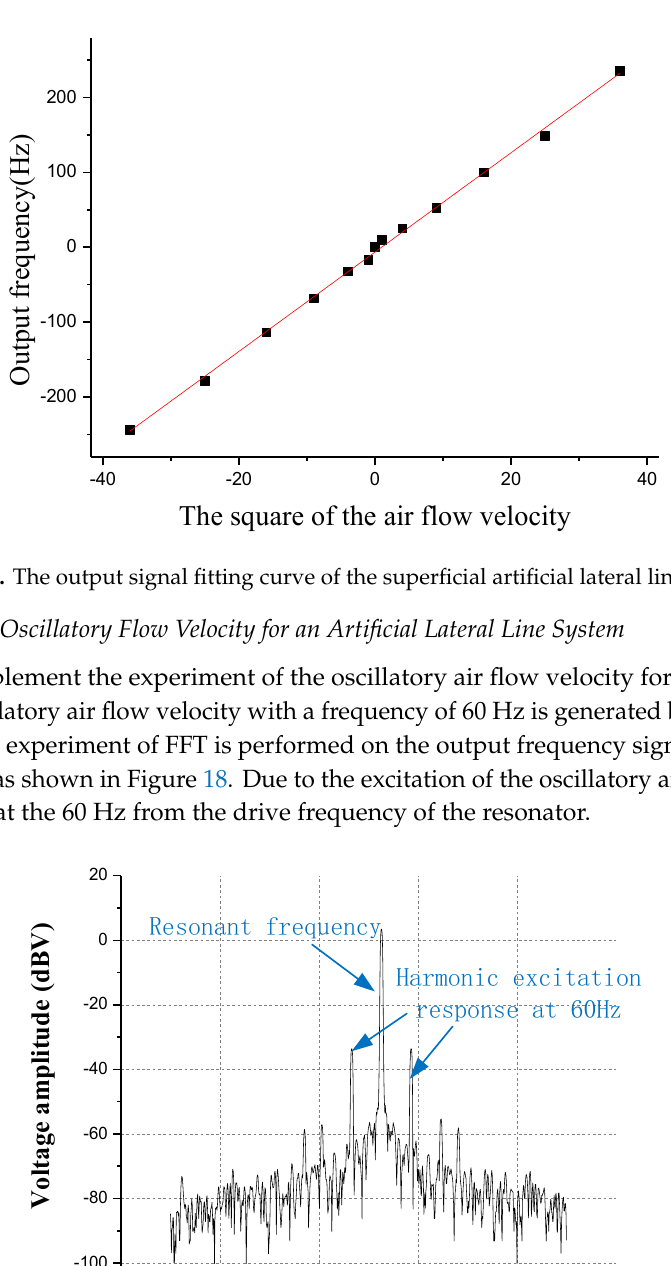
flow at 60 flow at 60 Hz.